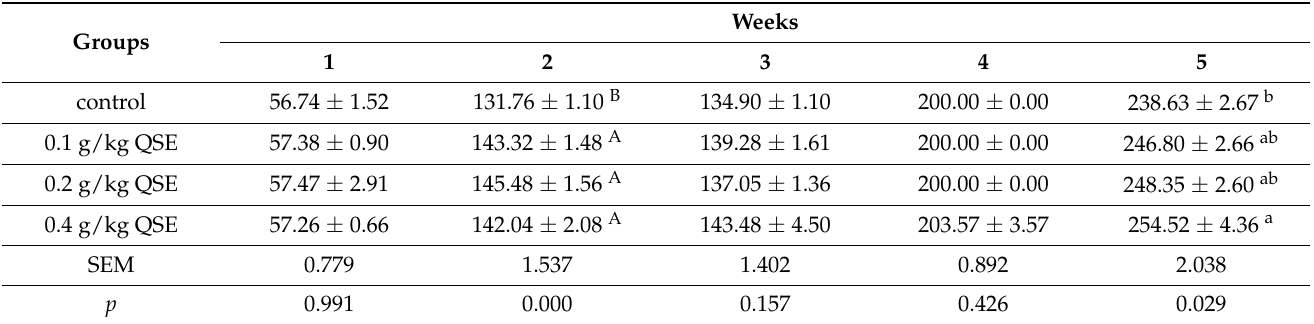
Table 4. Weekly feed consumption of experimental groups